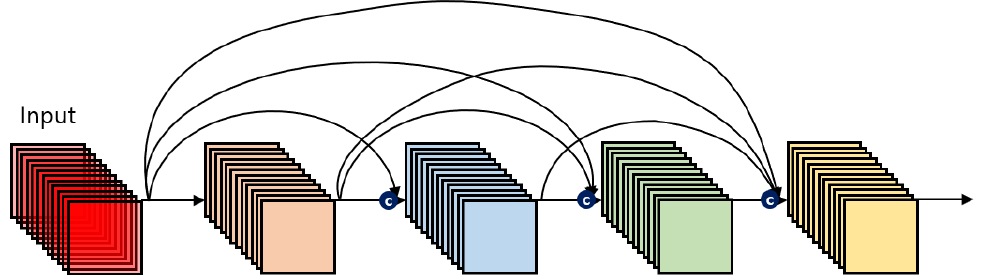
Figure 5. An example of dense connectivity. The square means the input feature maps with several channels. The curve connects the previous feature map with next layer feature map using channel- wise